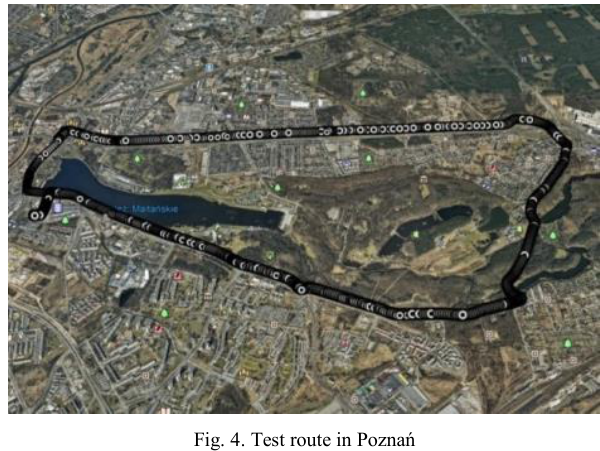
Fig. 4. Test route in Poznań